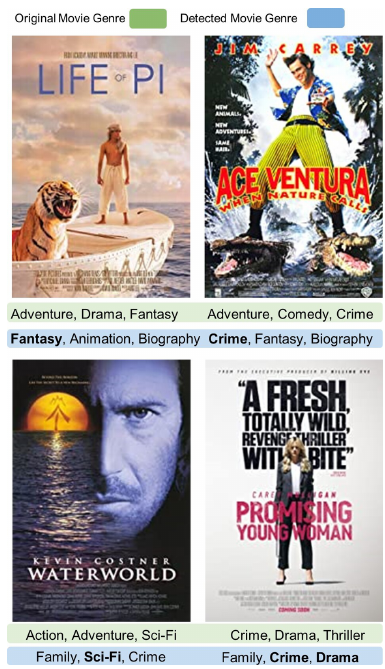
Figure 8. Example of movie posters that are classified by the proposed model.